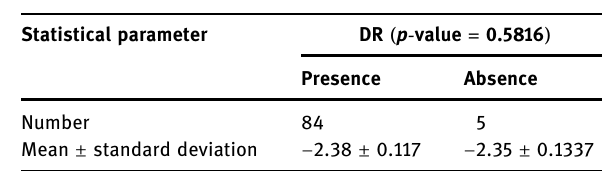
Table 2: Standard deviation and mean for DR in DIARETDB - 1